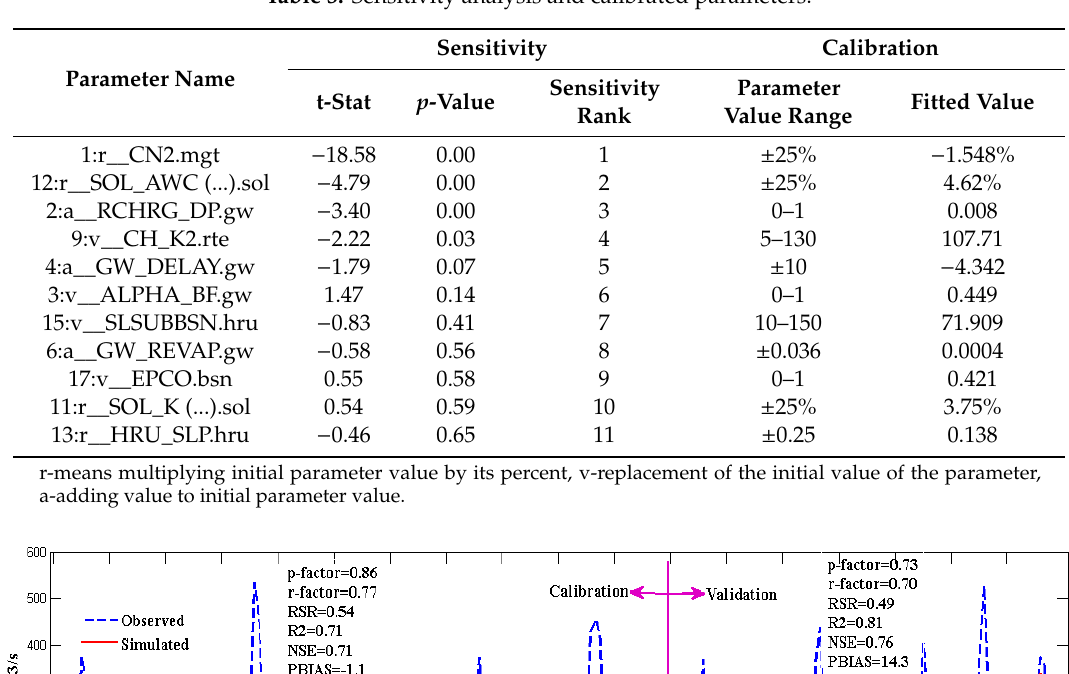
Table 3. Sensitivity analysis and calibrated parameters.